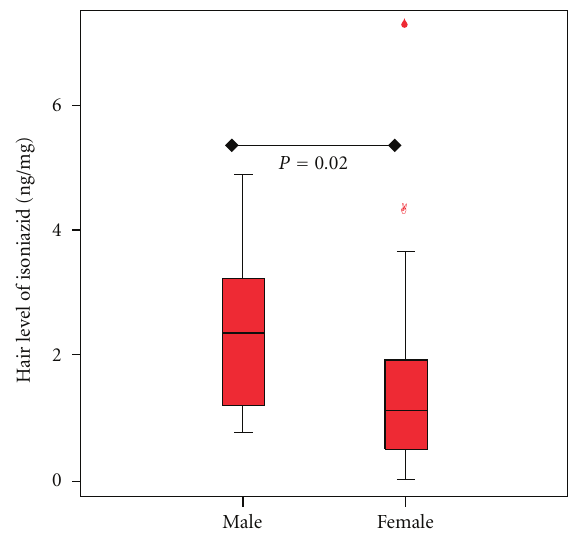
Figure 2: Isoniazid concentration in hair and gender.